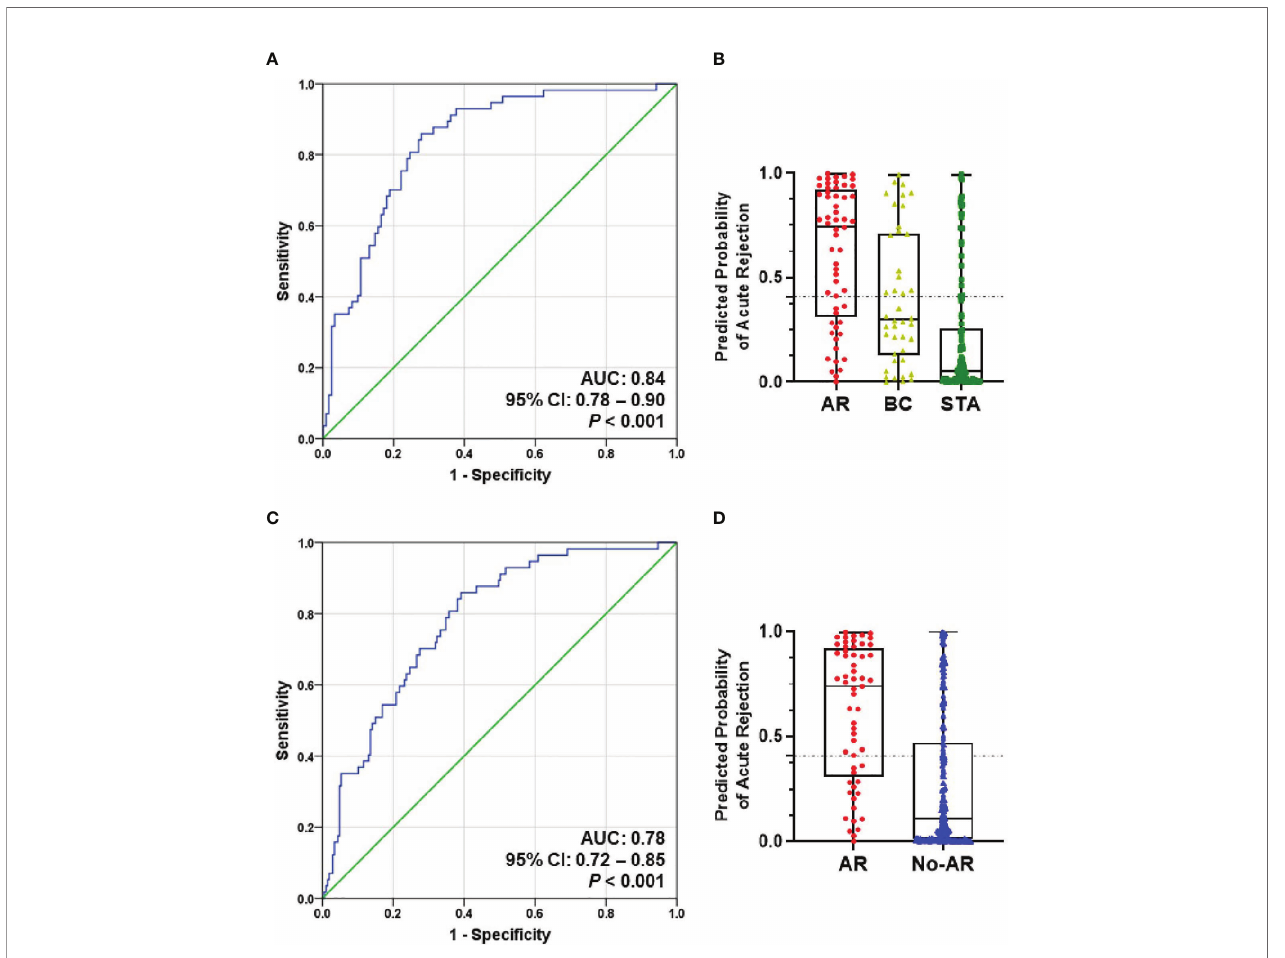
FIGURE 4 | The prediction performance of the signature in the validation set. (A) ROC curve of the AR predicted probability for distinguishing AR (n=57) from STA (n=122) in the QC-passed samples shows the AUC of 0.84 (95% CI, 0.78-0.90; P<0.001). (B) The box plot shows the AR predicted probability of the signature with the fi xed cut-off point (0.40889) in AR (n=57), BC (n=42), and STA (n=122), and the signature yielded 77% accuracy, 70% sensitivity, 80% speci fi city, 63% positive predictive value (PPV), and 85% negative predictive value (NPV). The horizontal line within each box represents the median, the bottom and top of each box represents the 25th and 75th percentile value, and the I bar represents the 5th and 95th percentile value. The plus symbol represents the mean, and the dots indicate outliers. (C) ROC curve of the predicted probability for distinguishing AR from No-AR (STA + OGIs, n=207) in the QC-passed samples is shown. The AUC value of the signature was 0.78 (95% CI, 0.72-0.85; P<0.001). (D) The box plot shows the AR predicted probability of the signature with the fi xed cut-off point (0.40889) in AR (n=57) and No-AR (n=207), and the signature yielded 72% accuracy, 70% sensitivity, 72% speci fi city, 41% positive predictive value (PPV), and 90% negative predictive value (NPV).